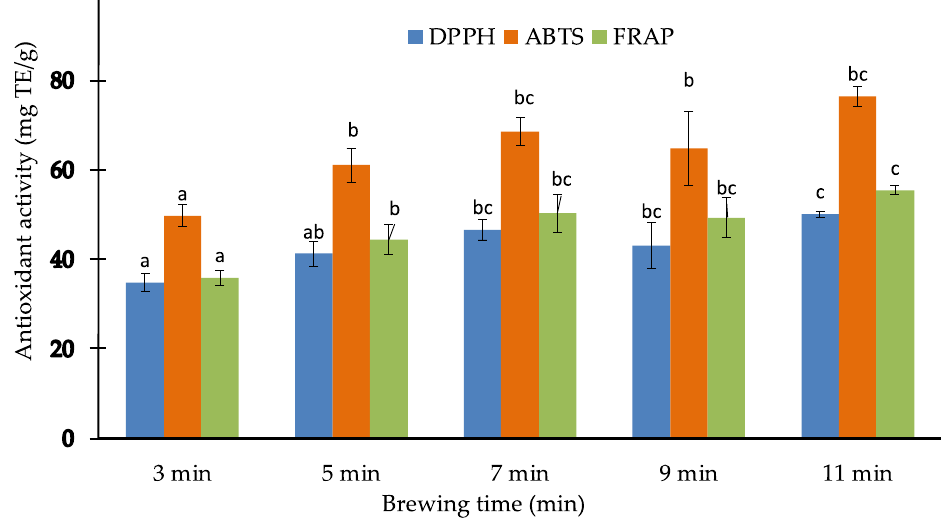
Figure 3. Antioxidant properties of tea infusion brewed at different time. Data are means ± standards deviations. Data for each antioxidant assay (DPPH, ABTS or FRAP) not sharing similar letters are significantly different at p < 0.05.